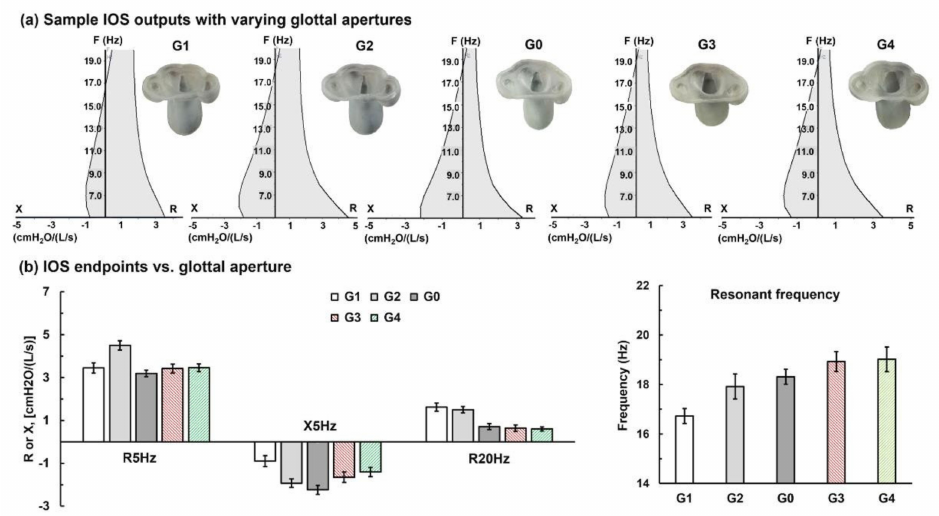
Figure 4. IOS characterization of the mouth–lung (G6) models with varying glottal apertures; ( a ) sample IOS outputs for the models GA1 (narrowest), GA2 (narrower), GA0 (normal), GA3 (wider), and GA4 (widest); ( b ) comparison of ISO endpoints (R5Hz, X5Hz, R20Hz, and resonant frequency) among the five models G0–4. The variables in ( a ) are the resistance R (cmH 2 O/(L/s)) in the positive x -axis, reactance X (cmH 2 O/(L/s)) in the negative x -axis, and frequency (Hz) in the y -axis.